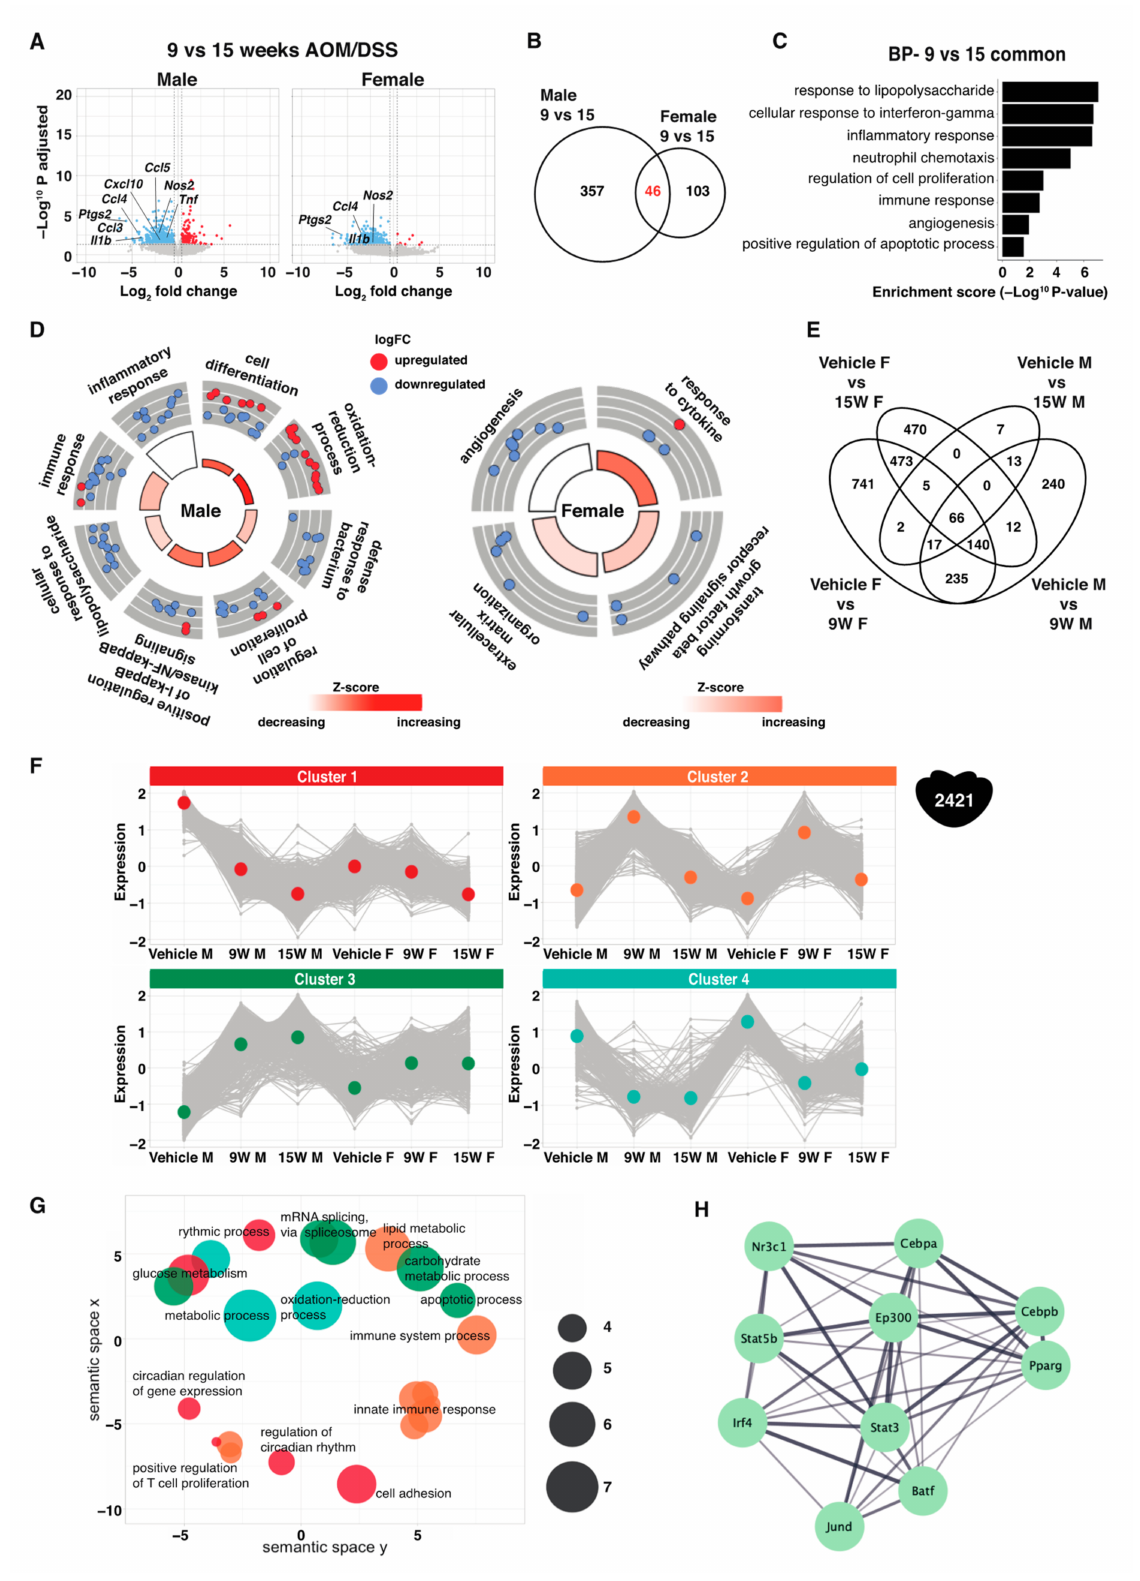
Figure 5. Sex differences in the response to acute and chronic inflammation. ( A ) Volcano plot showing DEGs between 9 weeks and 15 weeks of AOM/DSS treatment. ( B ) Venn diagram illustrating common and sex-specific responses after 15 weeks of AOM/DSS treatment compared to at 9 weeks. ( C ) BP enrichment analysis of the common and ( D ) sex-specific DEGs between 9 and 15 weeks of